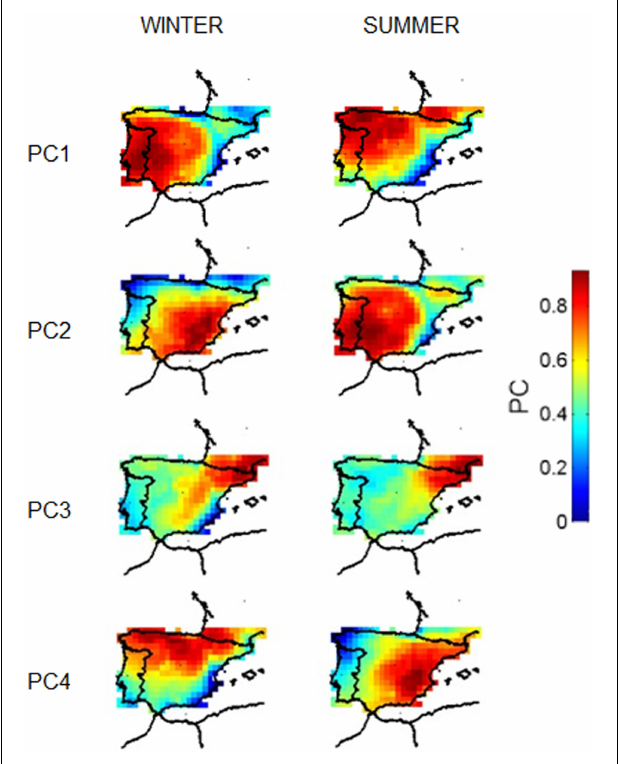
FIGURE 5 | First four PCA loadings for winter (left panel) and summer (right